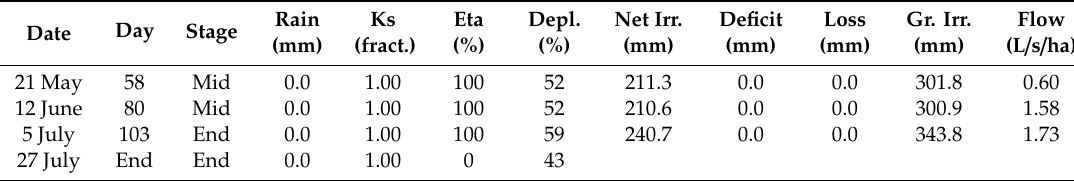
Table 9. Irrigation schedules for white